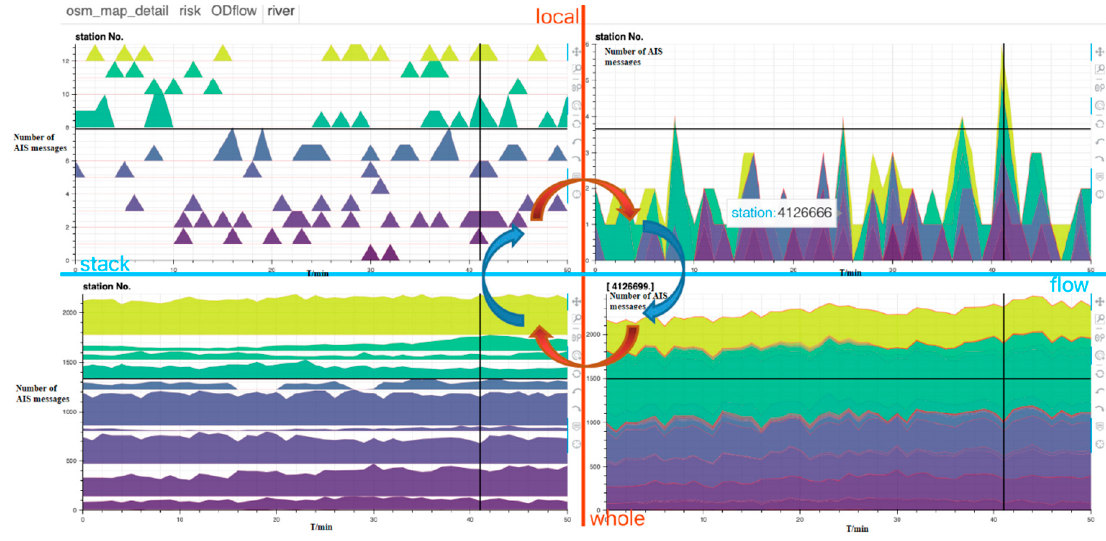
Figure 5. Four quadrant stack graph.